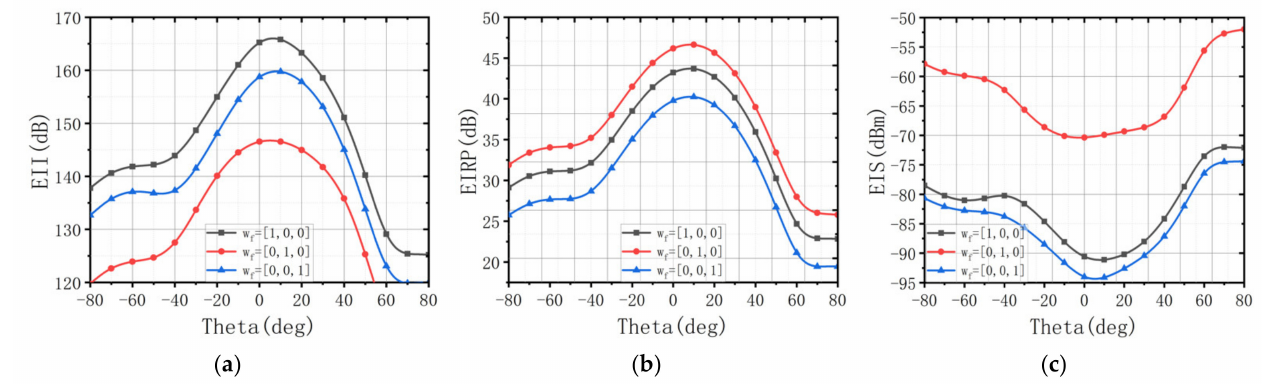
Figure 10. ( a ) EII with different transmit power. ( b ) EIRP with different transmit power. ( c ) EIS with different transmit power.